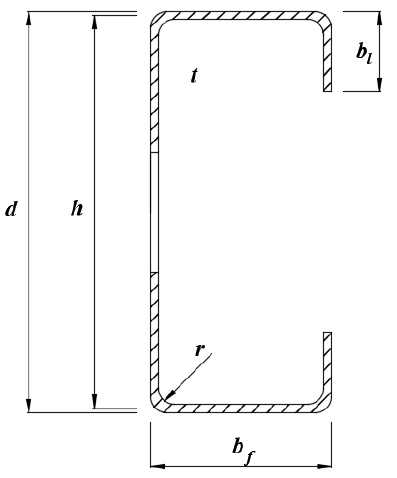
Figure 4. Definition of symbols from the published experiments.